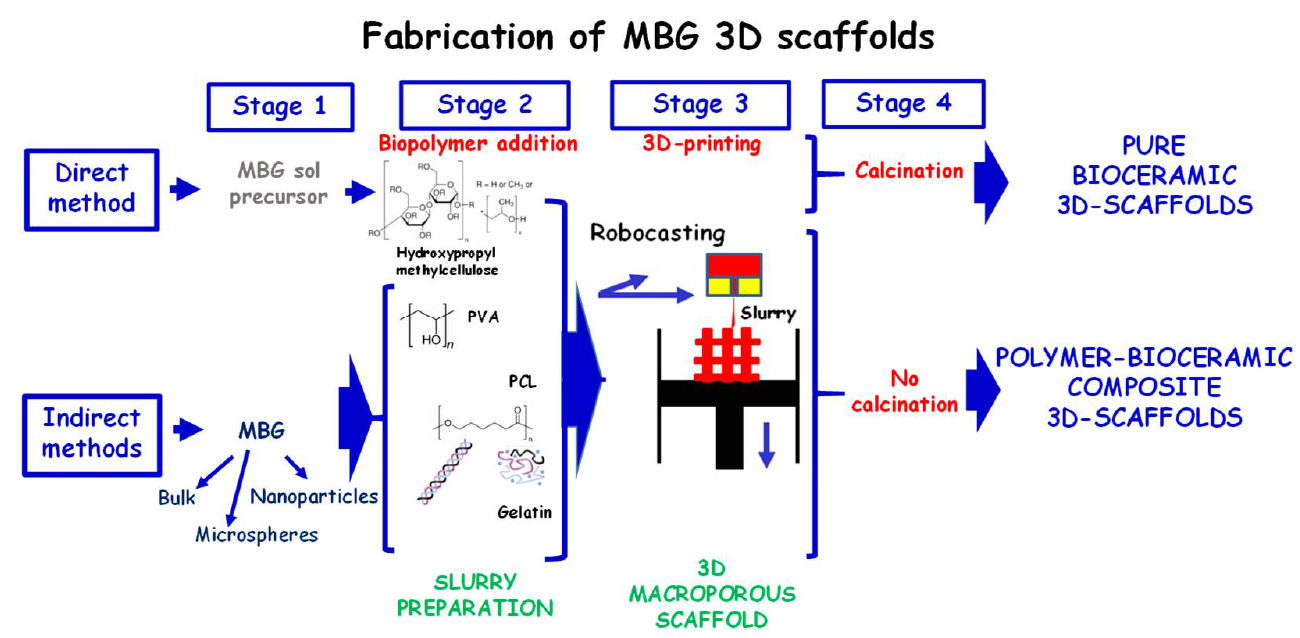
Figure 4. Different approaches for the fabrication of MBG-based 3D scaffolds by rapid prototyping Figure 4. techniques.